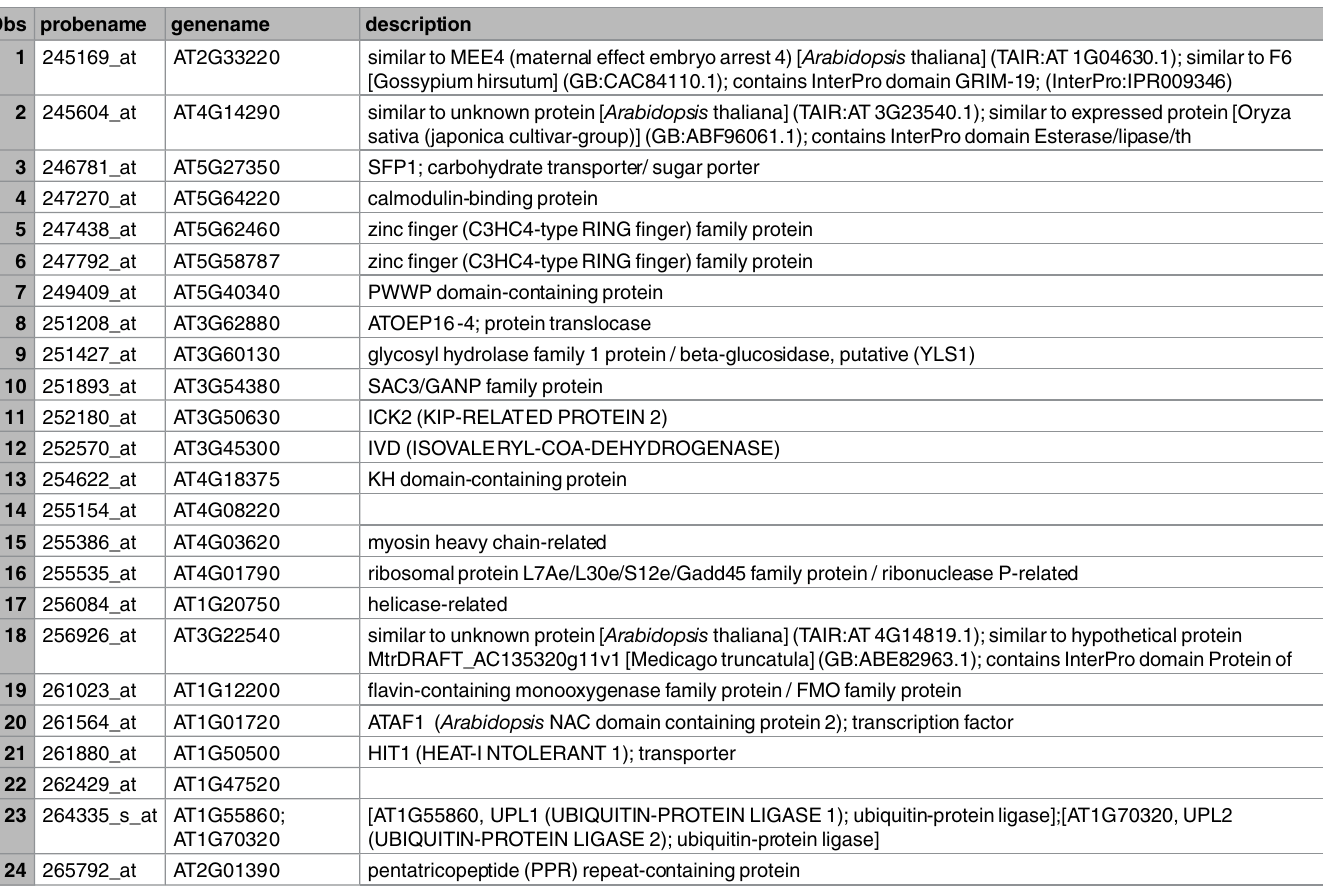
Table 1. Functionaldescriptions of 24 candidatespredictingPAO expression. The 24 candidates predictingPAO levels in the forward and stepwise methodmultiplelinearregressionmodelsof the GSE55907datasetwere identifiedby theirfunctionsthroughperformingSQL joins between tables containing gene names and functions. In particular, probename_261564_atwas found to be relevant due to its transcription factor capacity. Obs probename genename